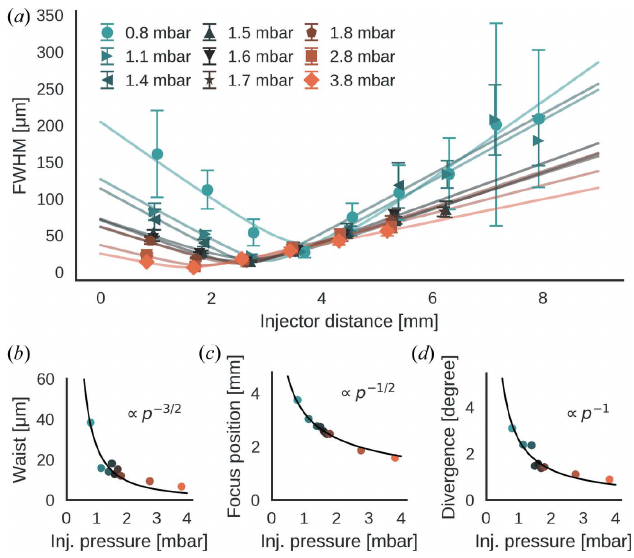
Figure 4 Scaling laws for the particle-beam focus with respect to entrance pressure. ( a ) Particle-beam widths (FWHM) for a range of pressures (see legend) are plotted against the distance from the injector tip. Particles were polystyrene spheres of 100 nm in diameter. The experimental data can be approximated with a Gaussian-beam model (solid lines). Scaling laws [solid lines in ( b ), ( c ) and ( d )] were identified for the model parameters as functions of the entrance pressure p . ( b ) The particle-beam waist scales as p (cid:3) (3/2) . ( c ) The distance between particle focus and injector tip scales as p (cid:3) (1/2) . ( d ) The particle-beam divergence scales as p (cid:3) 1 .